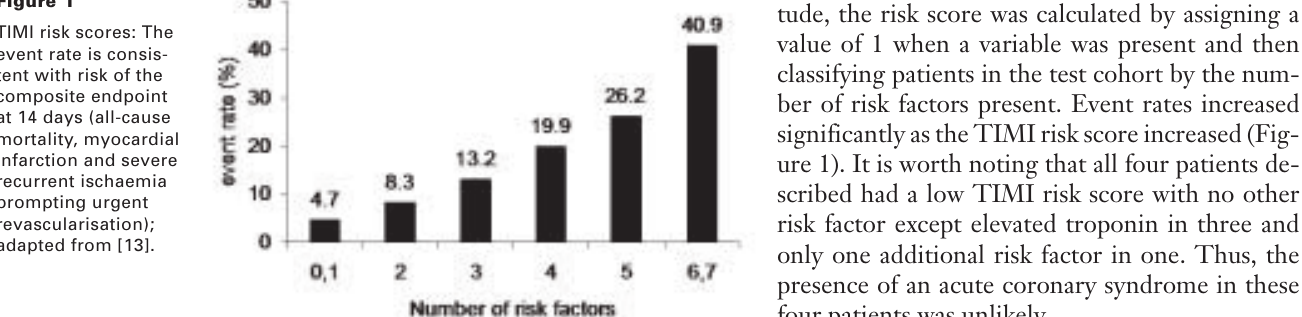
TIMI risk scores: The event rate is consis- tent with risk of the composite endpoint at 14 days (all-cause mortality, myocardial infarction and severe recurrent ischaemia prompting urgent revascularisation); adapted from